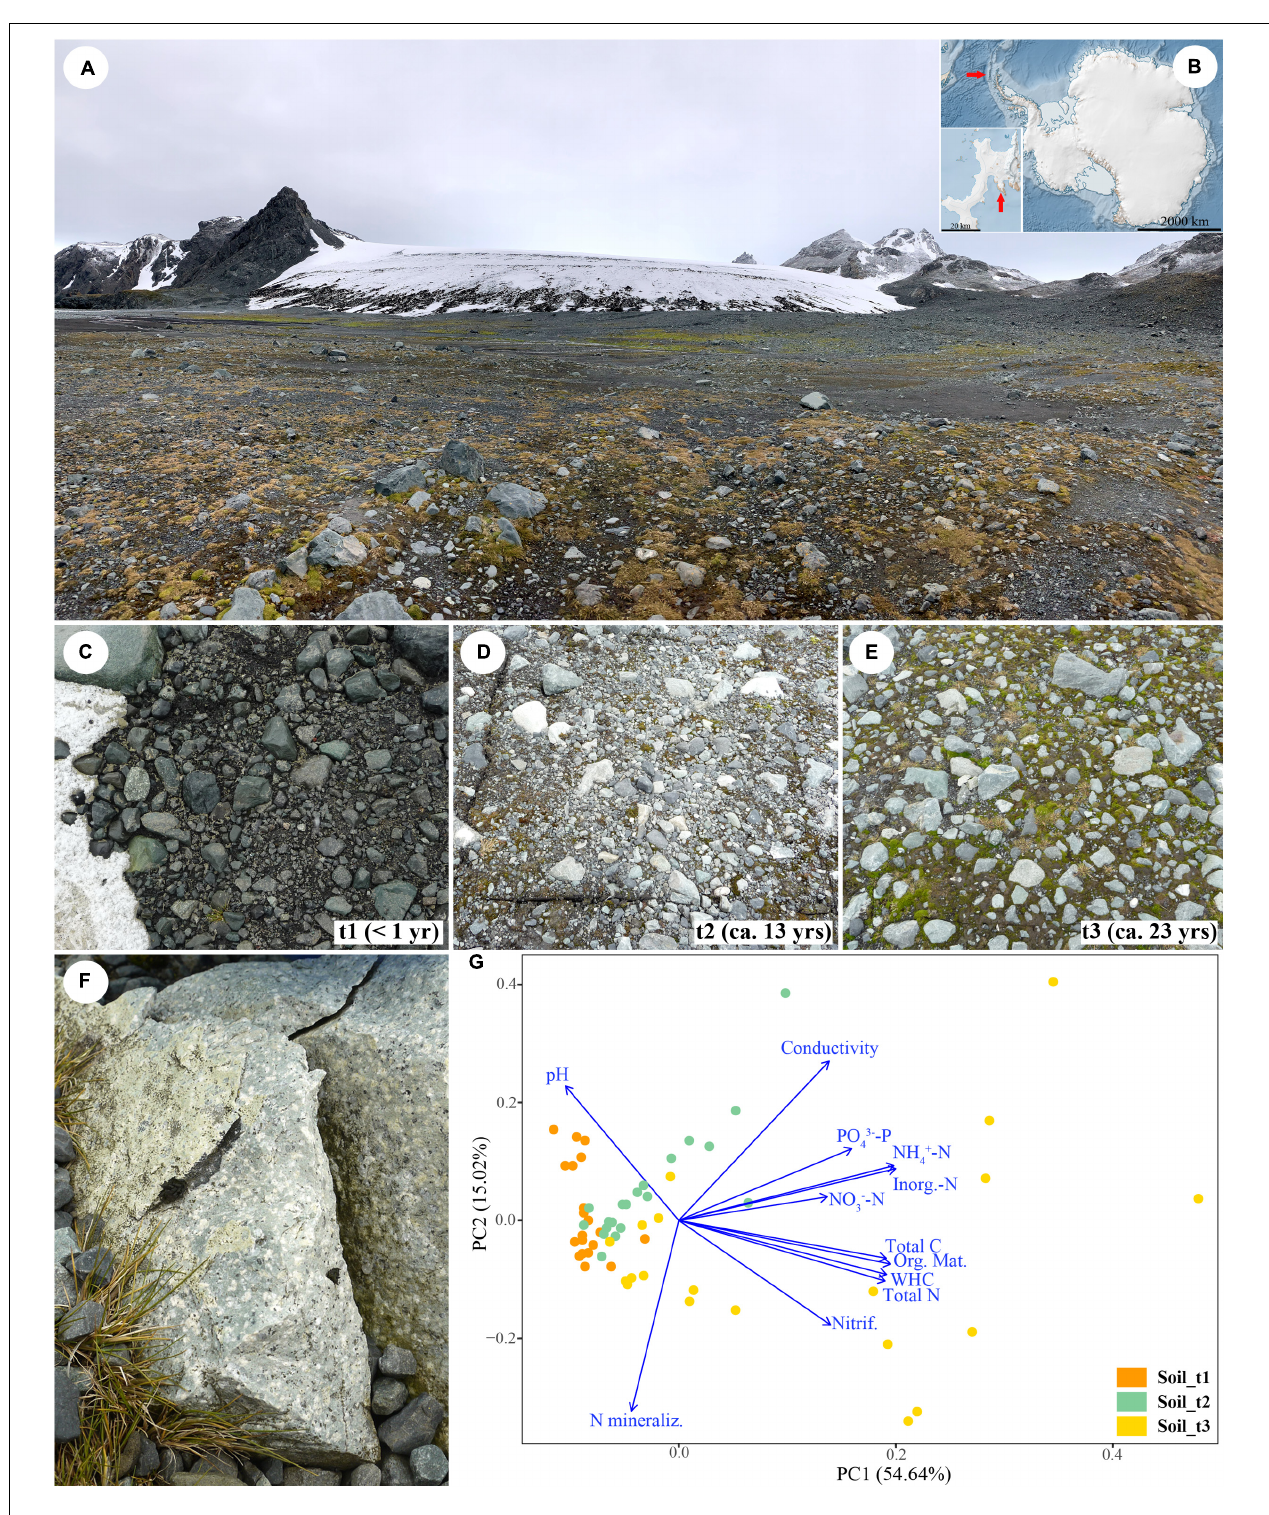
FIGURE 1 | Overview of the Sally Rocks tongue of the Hurd Glacier (A) located on Livingston Island, South Shetland Islands, Antarctica (B) . Arrows indicate the geographic situation of the island (Antarctica map), and the Hurd Peninsula (inset). Sampling sites ranging from bare soils close to the glacier terminus (t1, C ) to areas increasingly dominated by mosses that represent ca. 13 (t2, D ) and 23 (t3, E ) years since glacial retreat. (F) Detail of a sampled rock. (G) Ordination graph illustrating the outcome of a Principal Component Analysis (PCA) of soil data from 60 samples distributed in a three-stage chronosequence and considering 12 explanatory variables. The first two principal components explained 69.66% of total